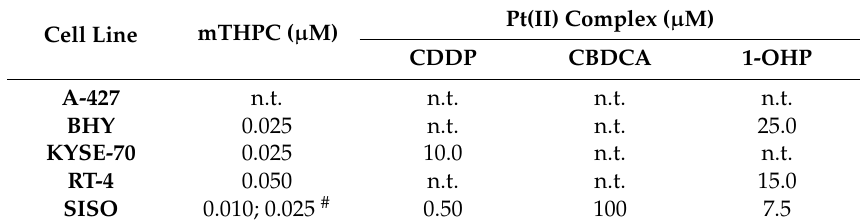
Table 3. Concentrations of mTHPC and Pt(II) complexes as combined in further analyses of ROS formation, phosphatidylserine externalization and cell cycle distribution. Only selected cell lines as well as promising concentrations for mTHPC and a corresponding Pt(II) complex were chosen depending on the outcome of the combination assay. Cell Line mTHPC ( µ